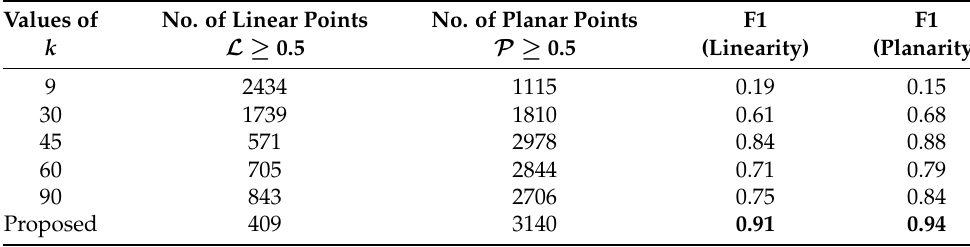
Table 7. Quantitative comparison of linearity and planarity for different neighbourhoods. Values